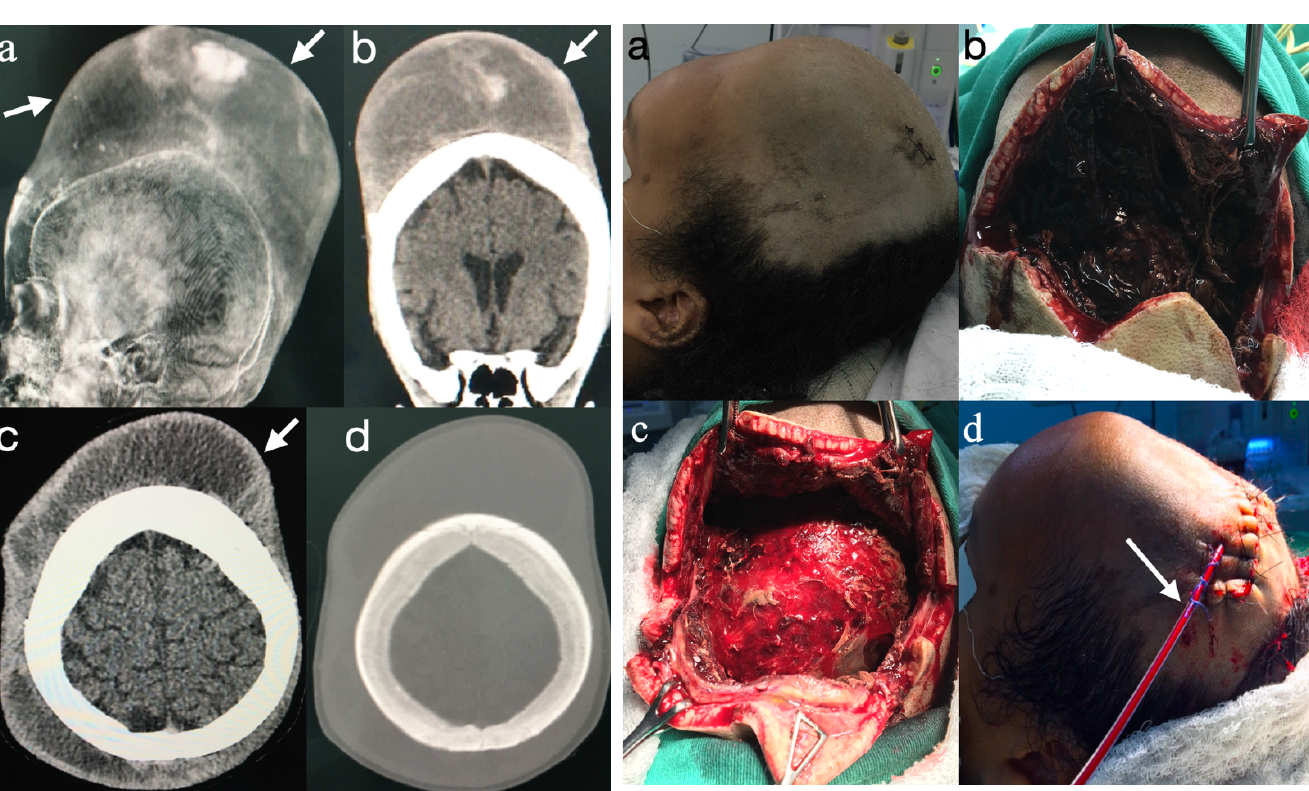
Figure 1- 3D CT scan (a), coronal CT scan (b) and axial CT scan (c) showing large subgaleal hematoma (white arrows); bone window (d) without skull fracture